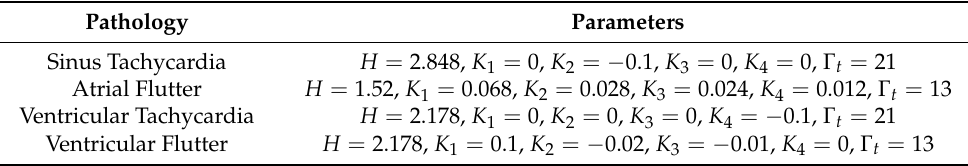
Table 2. Parameter values for the reaction–diffusion model.